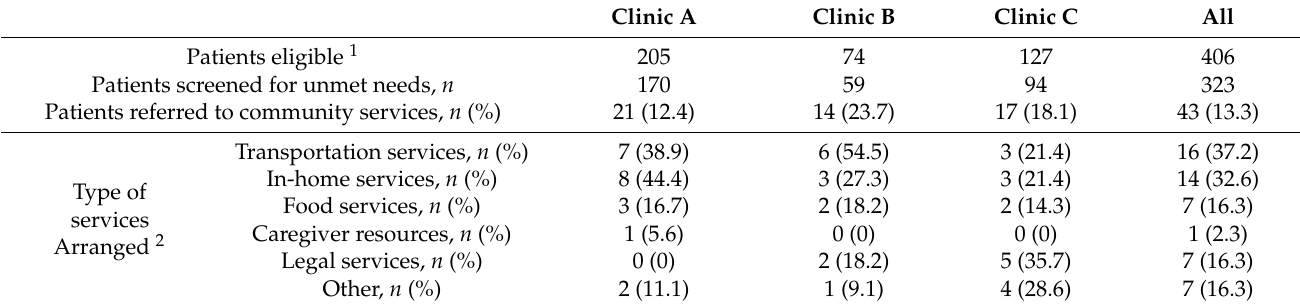
Table 4. Number of patients 65 and older screened and referred to community services by primary care